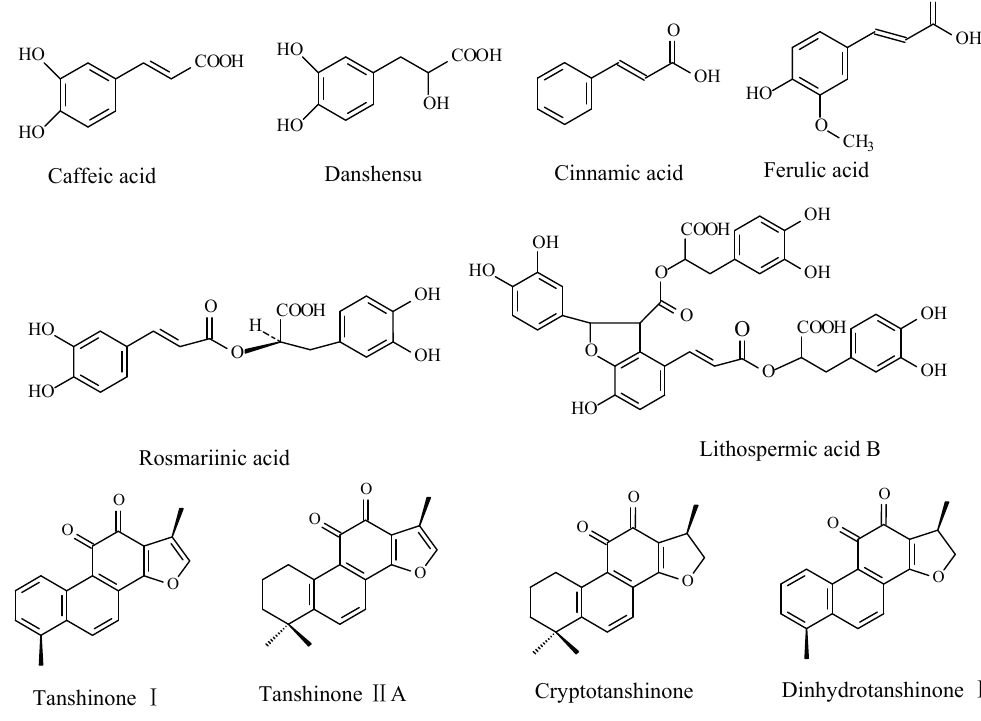
Figure 1. The chemical structure of ten compounds in S. miltiorrhiza have been studied in this article. Six water-soluble phenolic acids and four lipid-soluble